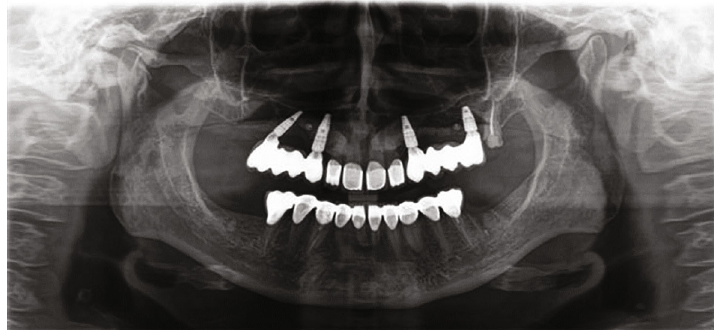
Figure 10: Panoramic image 6 months